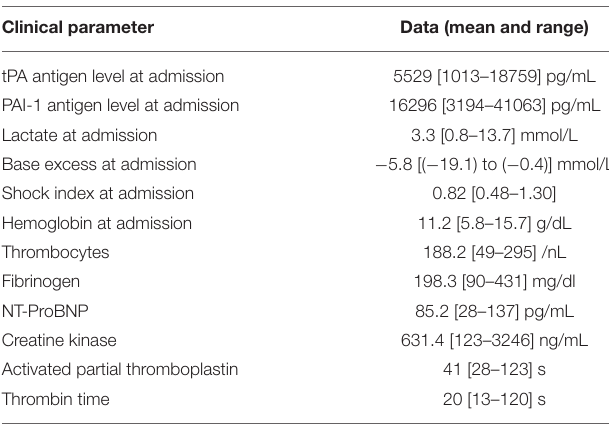
TABLE 2 | Clinical parameters at